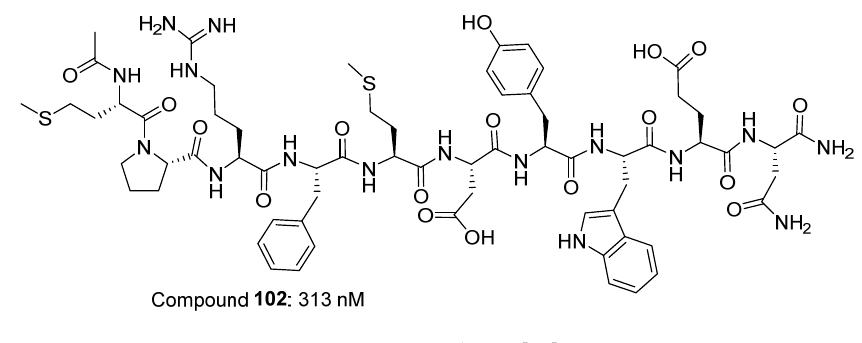
Figure 6. Peptide 102 [57].